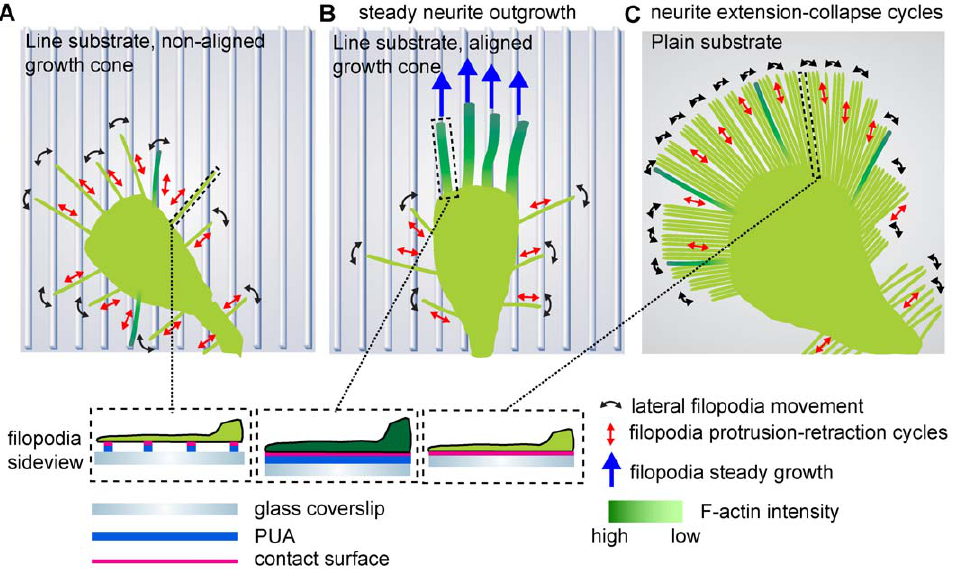
Figure 6. Model of neurite guidance in response to nanotopographical cues. ( A ) Line substrate, unaligned growth cone. Filopodia scan the line substrate through lateral scanning and protrusion/retraction events. Only few filopodia align on the lines and thus almost all filopodia sense only discrete adhesion points to the ECM. ( B ) Line substrate, aligned growth cone. Through stochastic sensing, multiple filopodia have aligned on the line substrate and have assembled an F-actin rich cytoskeleton that stabilizes them. On the distal part of the growth cone, non-aligned, unstable filopodia continue to operate, suggesting a crosstalk between both filopodia populations. This stabilizes the growth cone leading to steady neurite outgrowth. ( C ) Plain substrate. Unrestricted access to ECM leads to a large amount of long filopodia, none of which can be stabilized by a robust F-actin cytoskeleton. This is accompanied with a high frequency of neurite collapse events.